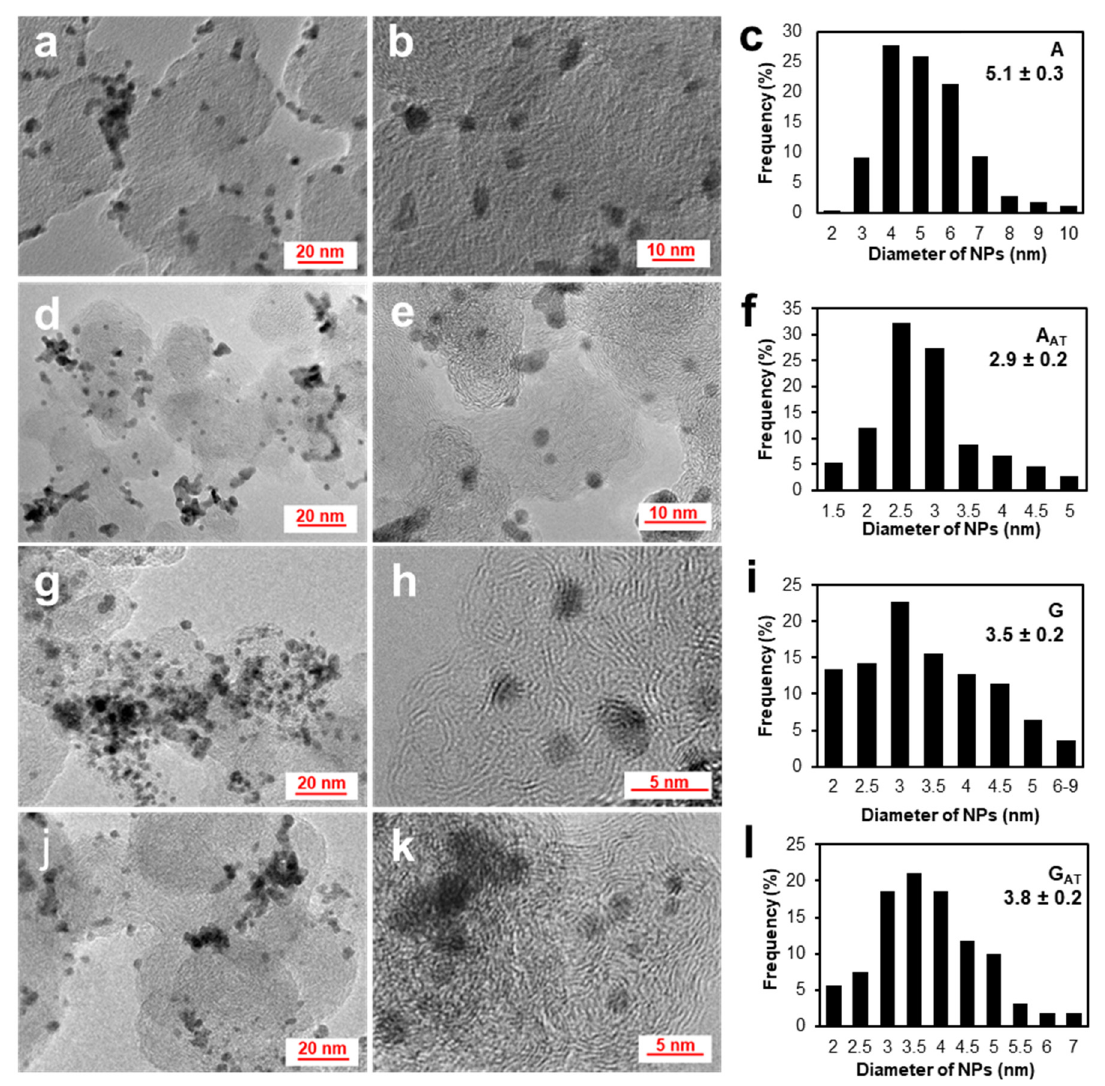
Figure 3. The TEM micrographs of the PtCu/C sample: A ( a , b ), A AT ( d , e ), G ( g , h ), G AT ( j , k ), and the histograms of the size distribution of NPs in the corresponding materials ( c , f , i , l ).